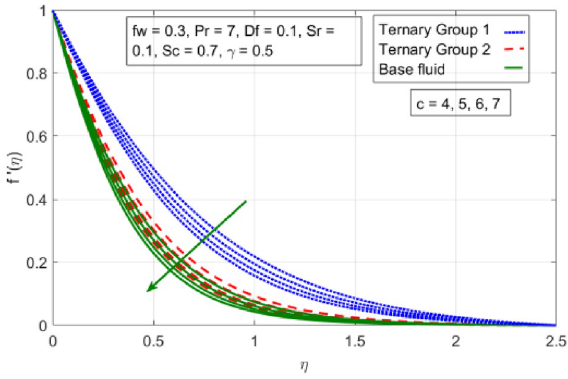
Figure 2. Variation in velocity profile against stretching ratio (c) along